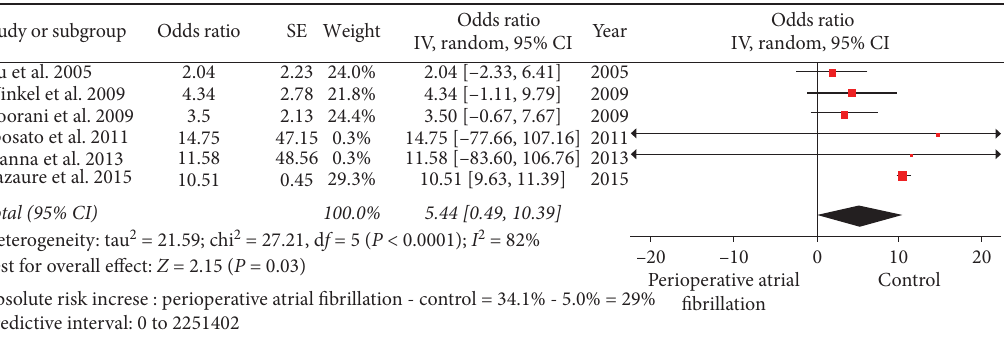
Figure 7: Forest plot comparing cardiac complications between atrial fibrillation group and control groups in patients undergoing noncardiothoracic surgery. The odds ratio of each included study is plotted. A pooled estimate of overall odds ratio (diamonds) and 95% confidence intervals (width of diamonds) summarizes the effect size using the random effects model. CI � confidence interval;